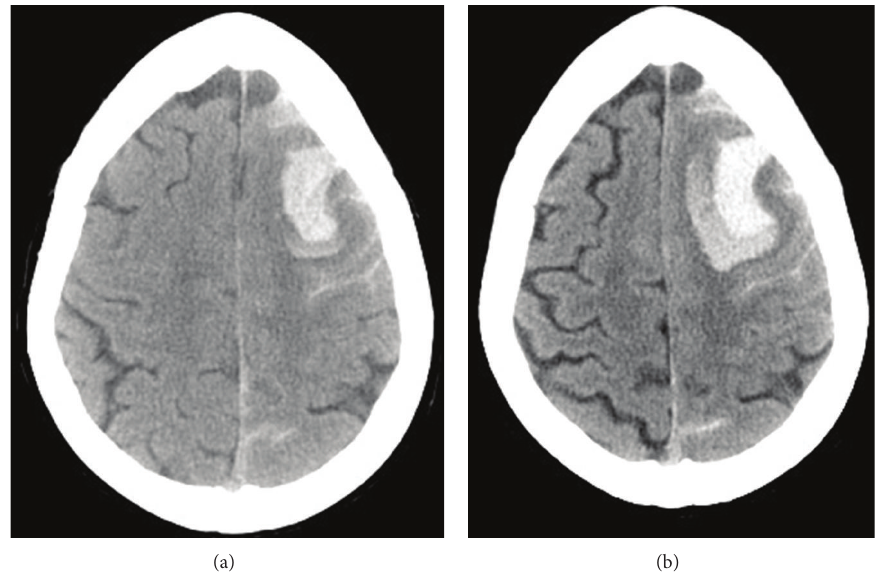
Figure 4: Initial cranial CT without contrast (a) and CT 12 hours later (b). A primary left superior frontal hematoma (3.3 × 1.5 cm) with minimal subarachnoid hemorrhage (a); significant hematoma expansion (4 × 2.5 cm) is evident on the repeat CT